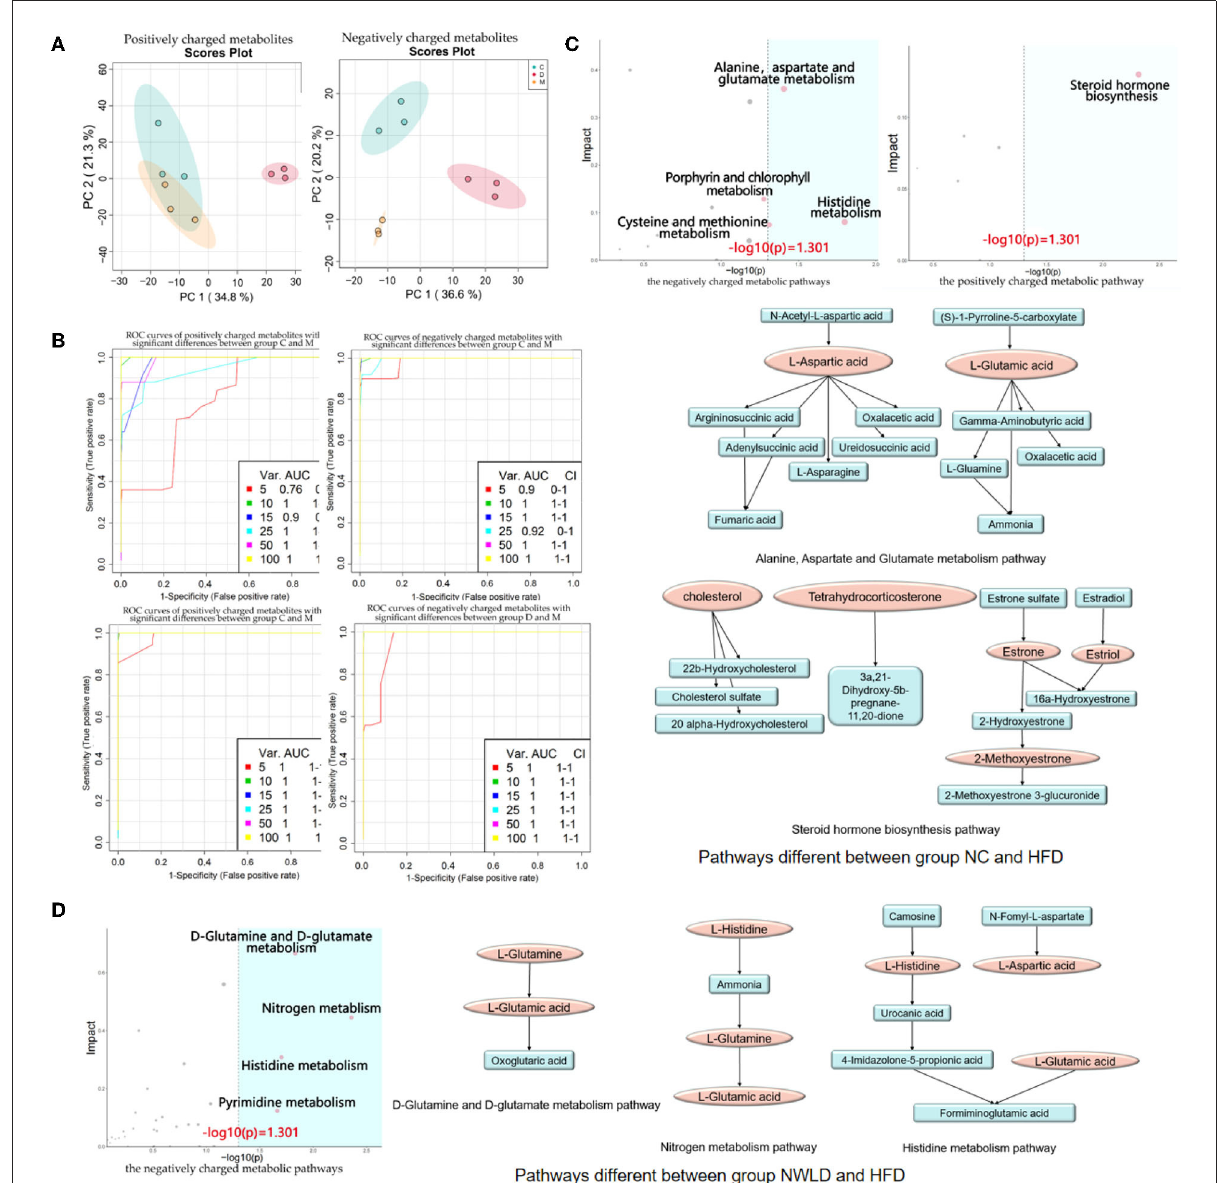
FIGURE3 Fecal untargeted metabolomics results. (A) Principal component analysis score plots for discriminating the fecal metabolome (positive and negative charge metabolites) from the NC, HFD, and NWLD groups; (B) SVM ROC curves. The abscissa indicates accuracy, and the ordinate indicates sensitivity. AUC values closer to 1 indicate a better predictive accuracy and a greater difference in metabolites between groups; (C) ORA and topology analyses of metabolic pathways with significant differences between groups NC and HFD. The horizontal coordinate represents the ORA p -value, and the blue area is significant ( p < 0.05). The vertical axis shows the impact value in the topology analysis. Maps of the main metabolic pathways are shown, including the alanine, aspartate, and glutamate metabolism pathways and steroid hormone biosynthesis; (D) ORA and topological analyses of the metabolic pathways with significant differences between groups NWLD and HFD and maps of the main metabolic pathways, including D-glutamine, D-glutamate, nitrogen, and histidine metabolism